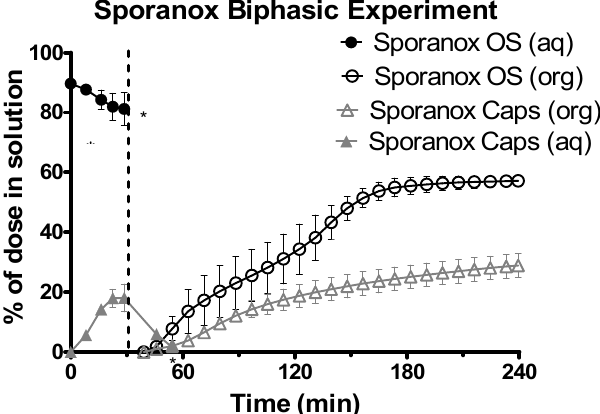
Figure 6. Drug release time profile for Sporanox ® formulations, dose equivalent to 5 mg API. Sporanox ® OS and Sporanox ® Capsules are represented by black circles and grey triangles respectively. Aqueous layer release is represented by filled points. Organic layer data are represented by the hollowed points. Dotted line indicates transition from gastric sector to intestinal sector. Each data point represents the mean ± SD ( n = 3). * indicates where UV blackout occurred in the aqueous phase due to precipitation and / or limitations of quantification. aq = aqueous layer. org = organic